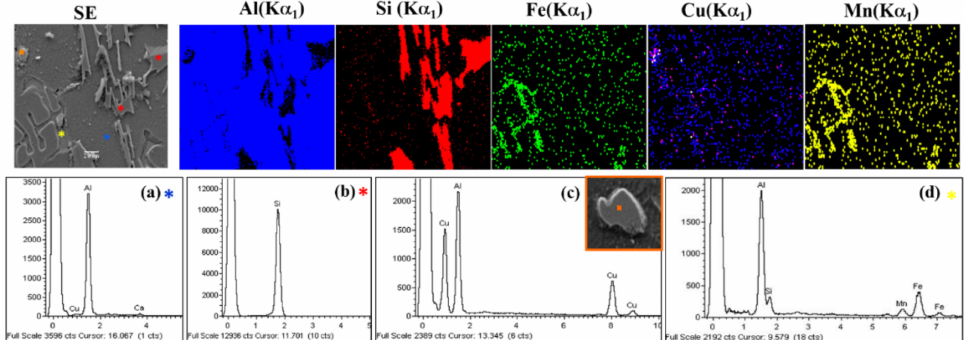
Figure 3. Mapping analysis of an area on the surface of the casting specimen, and 3 ( a – d ) X-ray spectra obtained at different points in the area as a function of the distribution of the elements.